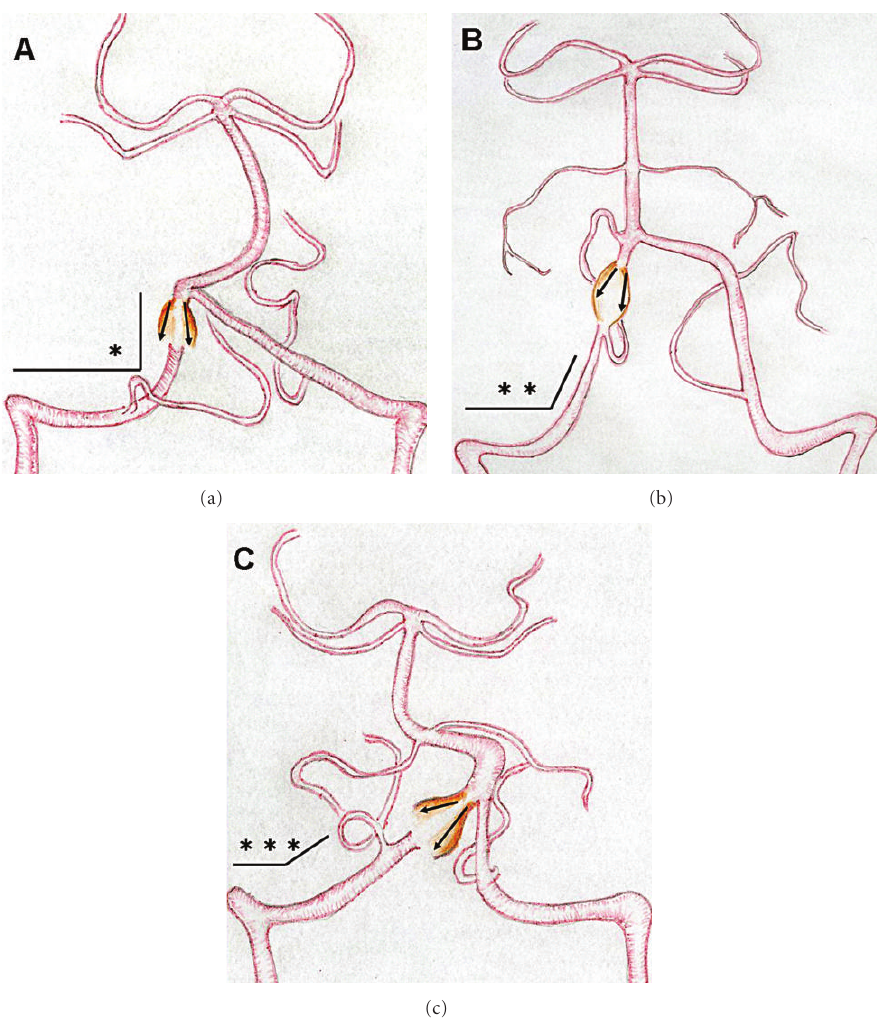
Figure 1: (a) Schematic drawing of a Type I vertebral artery showed no deviation of the running. ∗ : the configuration of the right vertebral artery was a sharp angle less than 90 defined as no deviation. Arrows show retrograde inflow into the pseudolumen from the distal entry of the dissection site. (b) Schematic drawing of a Type II vertebral artery showing mild-to-moderate deviation but not over the midline. ∗∗ : the configuration of the vertebral artery was an obtuse angle defined as mild-to-moderate deviation. The midline was defined as the line from the septum pellucidum to the anterior median fissure as assessed by basiparallel anatomic scanning (BPAS)—MR imaging. Arrows show retrograde inflow into the pseudolumen. from the distal entry of the dissection. (c): schematic drawing of a Type III vertebral artery deviating remarkably to the contralateral side over the midline. Arrows show retrograde inflow into the pseudolumen. from the distal entry of the